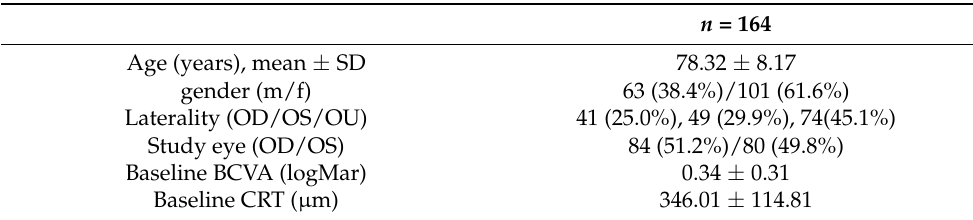
Table 1. Epidemiological and clinical baseline data of included patients. BCVA, best-corrected visual acuity; CRT, central retinal thickness; f, female; m, male; OD, right eye; OS, left eye; OU, both eyes; SD, standard